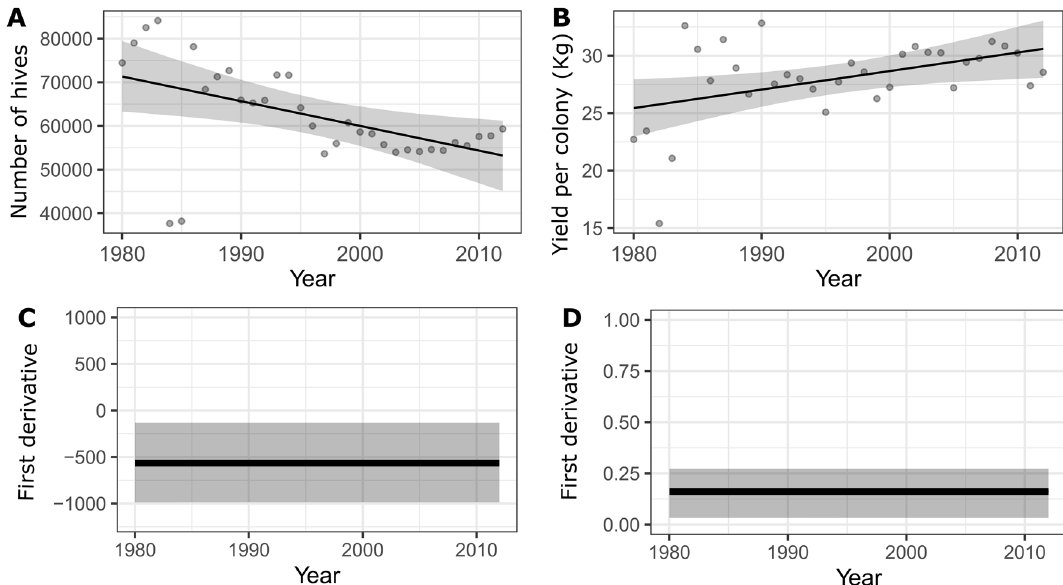
Figure 4. The estimated national average trend for: ( a ) the number of hives and ( b ) the average annual yield per hive (kg). The first derivative is estimated for the slope of ( c ) the number of hives and ( d ) the average annual yield per hive. The shaded area represents approximately 95% of the confidence intervals. The sections of the slope where the confidence interval does not include zero are indicated by the sections of the trend line in